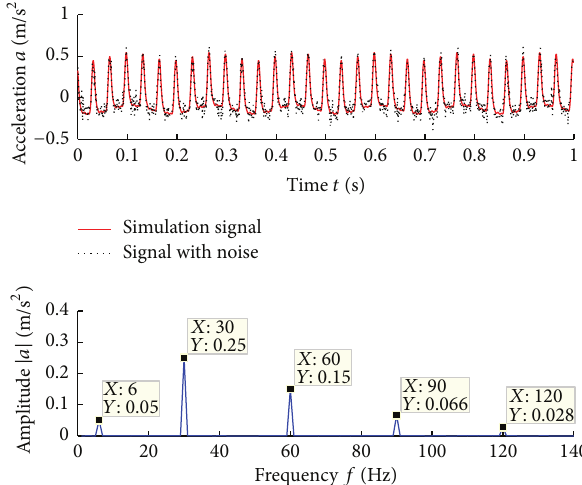
Figure 2: Simulated signals and their amplitude spectra.